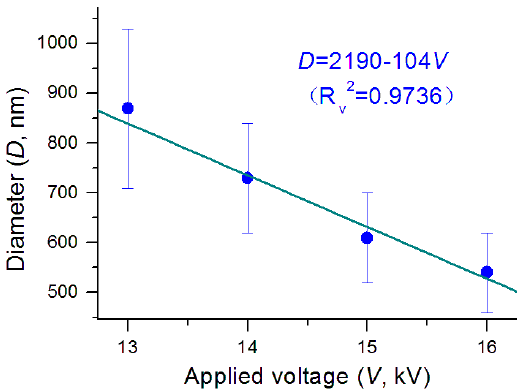
Figure 6. The influence of applied voltage on the size of prepared nanofibers.